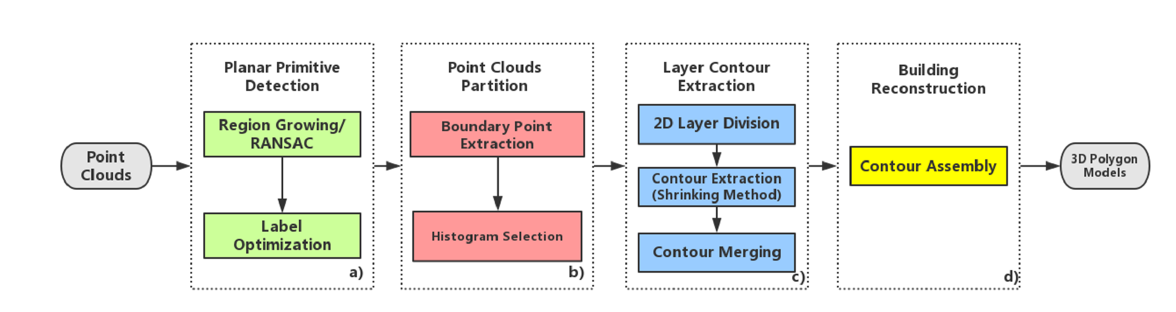
Figure 2. The flowchart of the proposed approach involving four major steps. ( a ) Planar primitive detection; ( b ) point clouds partition using boundary points; ( c ) layer contour extraction in the 2D space; ( d ) building